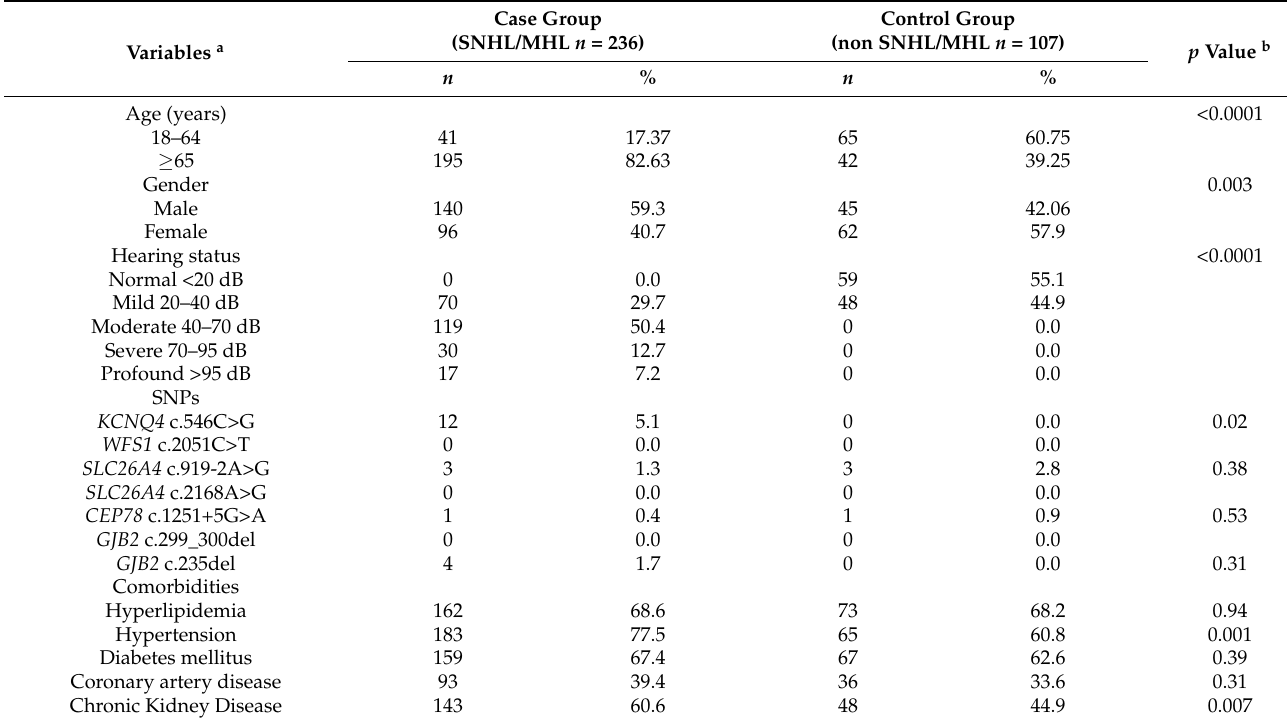
Table 2. Basic characteristics of study populations.